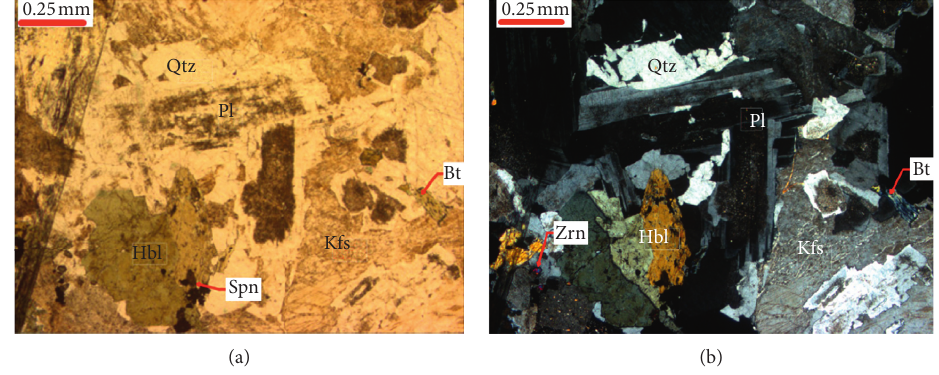
Figure 1: Polarizing microscope images. (a) Plane-polarized light and (b) cross-polarized